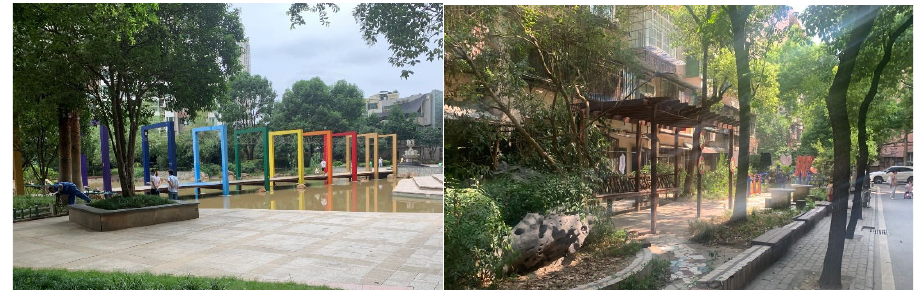
Figure 6. Public open spaces in a commodity-housing neighbourhood and old danwei